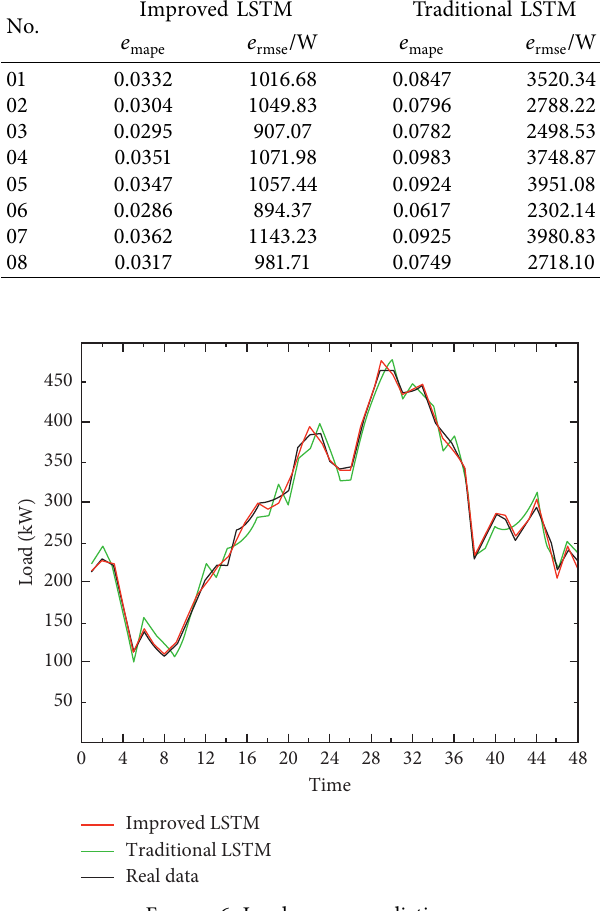
Figure 6: Load power